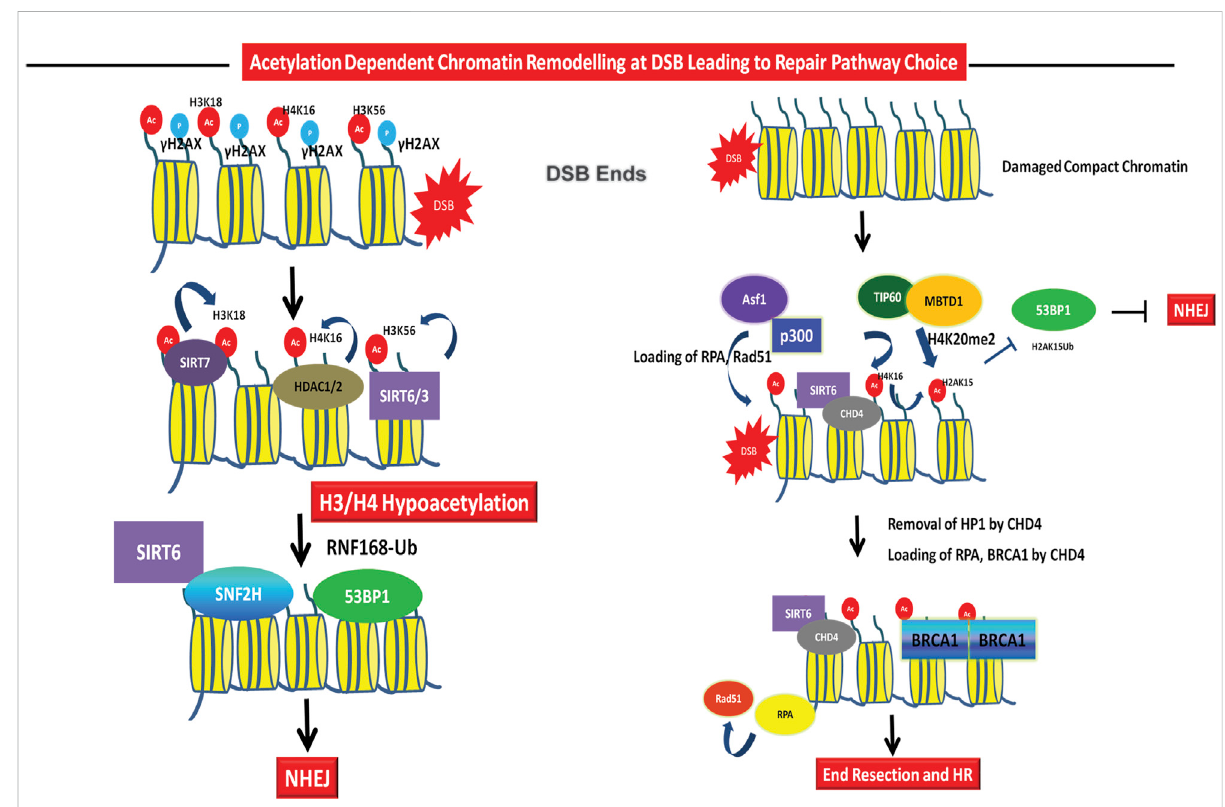
FIGURE 3 Role of acetylation in DSB repair pathway choice. Repair Pathway Choice- The early recruitment of HDACs like SIRT6, SIRT3, and HDAC1/ 2 leads to deacetylation of H3K56ac, H3K18ac, H4K16ac, etc. leading to chromatin compaction and recruitment of NHEJ factors 53BP1 and Ku70/ 80. SIRT6 dependent SNF2H recruitment aids in the recruitment of downstream DNA repair factors at G1 to facilitate NHEJ. The repair pathway choice for HRthroughacetylation ismediated via Tip60 dependentubiquitylation toacetylation switch atH2AK15, through H4K20me3 leading to inhibitory binding to 53BP1 and inhibition of NHEJ. Repair of damage in G2 or at compact chromatin regions require removal of heterochromatin protein like HP1 by CHD4. CHD4 is recruited by SIRT6 and this leadsto removal of HP1 leading to chromatin decompaction, recruitment of RPA and BRCA1 to facilitate HR. Asf1 and p300 also facilitates the recruitment of Rad51 and RPA at